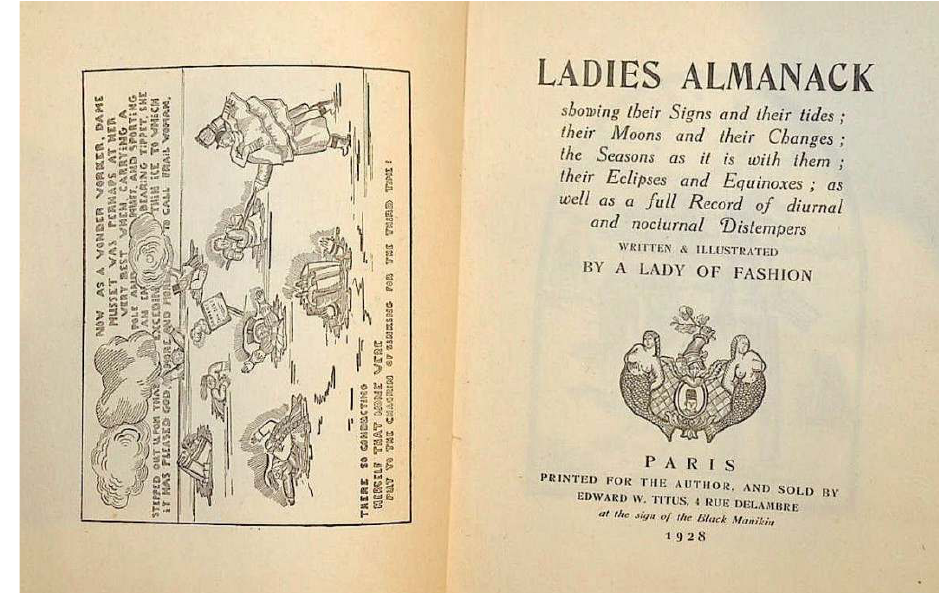
Figure 2: Frontispiece of Djuna Barnes’ ‘ The Ladies Almanack ’